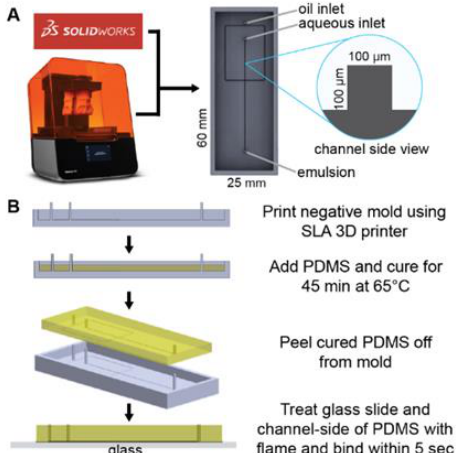
Figure 1. Microfluidic device design and fabrication. ( A ) A solid master mold was designed with Solidworks CAD software and printed with FormLabs Form3 SLA printer. ( B ) PDMS device fabrication process.